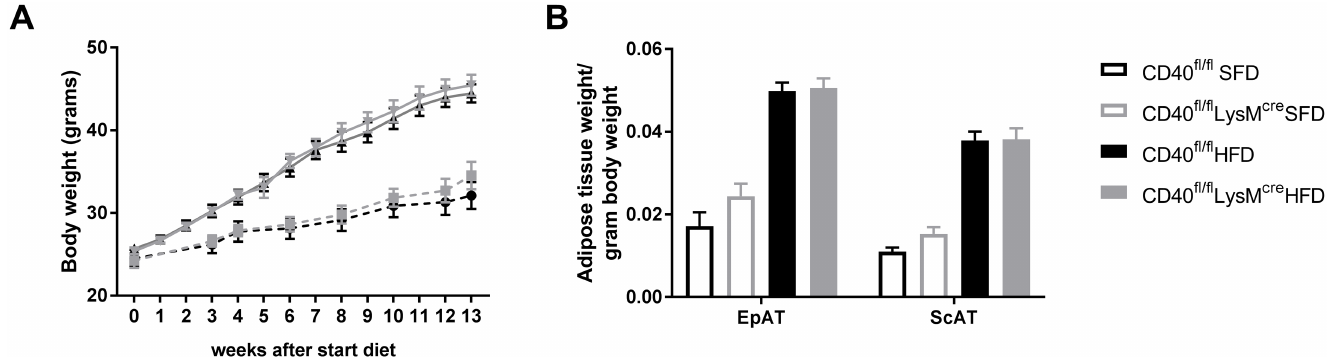
Fig 1. Body and adipose tissue weight of myeloid deficient mice. (A) Body weight of the high fat diet (HFD) CD40 fl/fl LysM cre and WT mice (n = 16/group) and the standard fat diet mice (SFD, n = 7/group) during 13 weeks of diet. (B) Tissue weights after 13 weeks of diet. Data is presented as mean ± SEM.